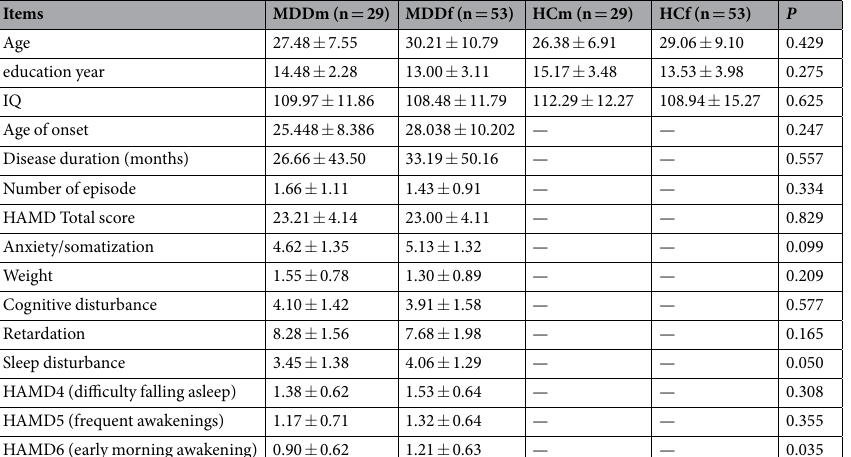
HAMD6 (early morning awakening) 0.90 ± 0.62 Table 1. Demographic and clinical characteristics of participants. MDD: Major Depressive Disorder; MDDm: male patients with major depressive disorder; MDDf: female patients with major depressive disorder. HCm: Healthy male control; HCf: Healthy female control. IQ: intelligence quotient. HAMD: Hamilton Depression Rating Scale; Anxiety/somatization: HAMD 10, 11, 12, 15, 17; Weight: HAMD 16; Cognitive disturbance: HAMD 2, 3, 9; Retardation: HAMD 1, 7, 8, 14; Sleep disturbance: HAMD 4, 5,